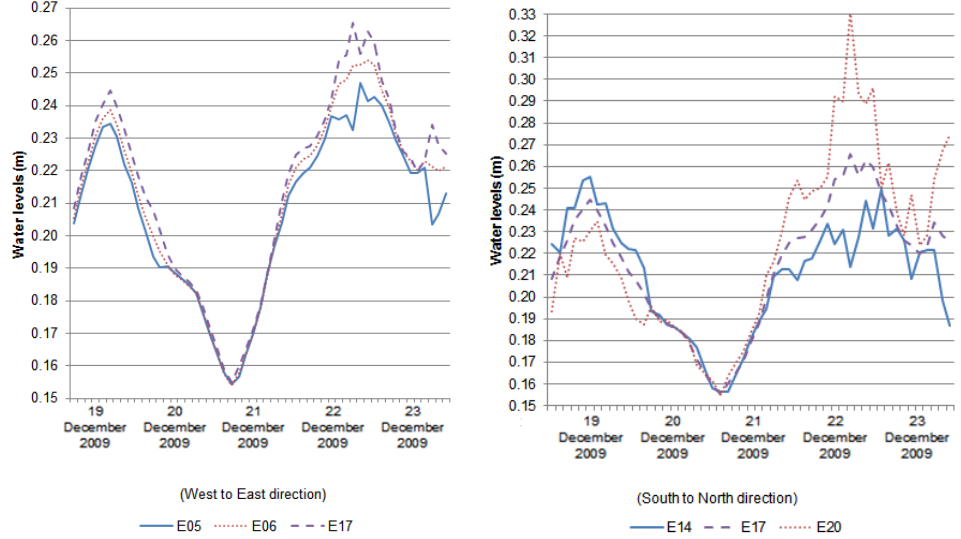
Figure 5. Time series of water levels at stations E05, E06, and E17 ( left ) and stations E14, E17, and E20 ( right ) from 19 December 2009 to 23 December 2009.